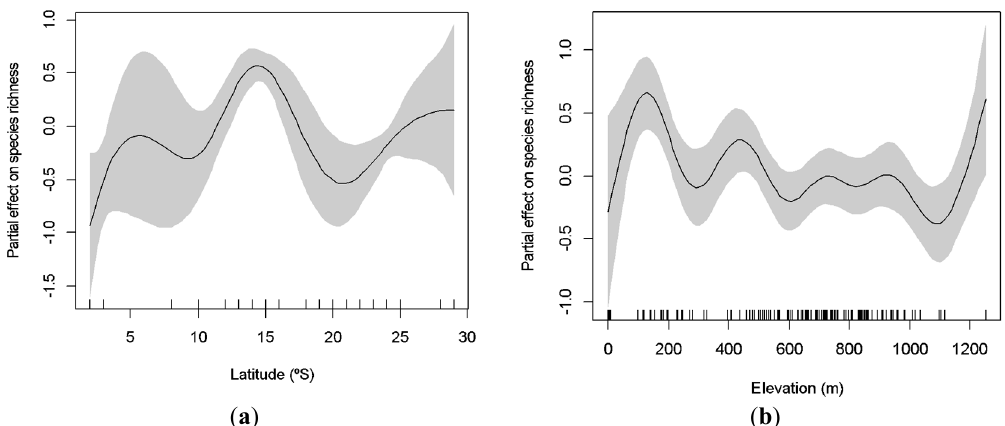
Figure 3. Generalized additive model (GAM)-derived effect of latitude ( a ) and elevation ( b ) on species richness of cave-dwelling bats. The value of 0 on the y-axis is the mean of richness. The approximate 95% confidence envelopes are indicated (grey shading). Tick marks on the x-axis are sampled data points.